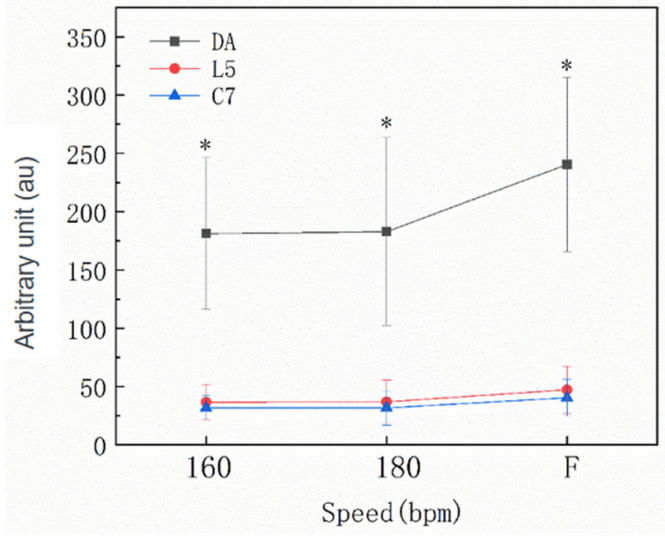
Figure 4. The amateur group total PlayerLoad responses to the Zapateado-3 footwork at 160 bpm, 180 bpm and the fastest speed level (F) for the dominant ankle (DA), the fifth lumbar vertebra (L5) and the seventh cervical vertebra (C7). * Denotes a significant main effect for the unit position. Significant main effects for unit position ( p < 0.001) as well as for the speed x po- sition interaction ( p ≤ 0.001) were identified. PLTOTAL values were higher for the DA (212.98 ± 72.27 au; CI = 201.30–224.66 au) compared with C7 (38.27 ± 14.70 au; CI = 26.59– 49.95 au; p < 0.001; d = 3.35) and L5 (44.15 ± 17.68 au; CI = 32.47–55.83 au; p < 0.001; d =